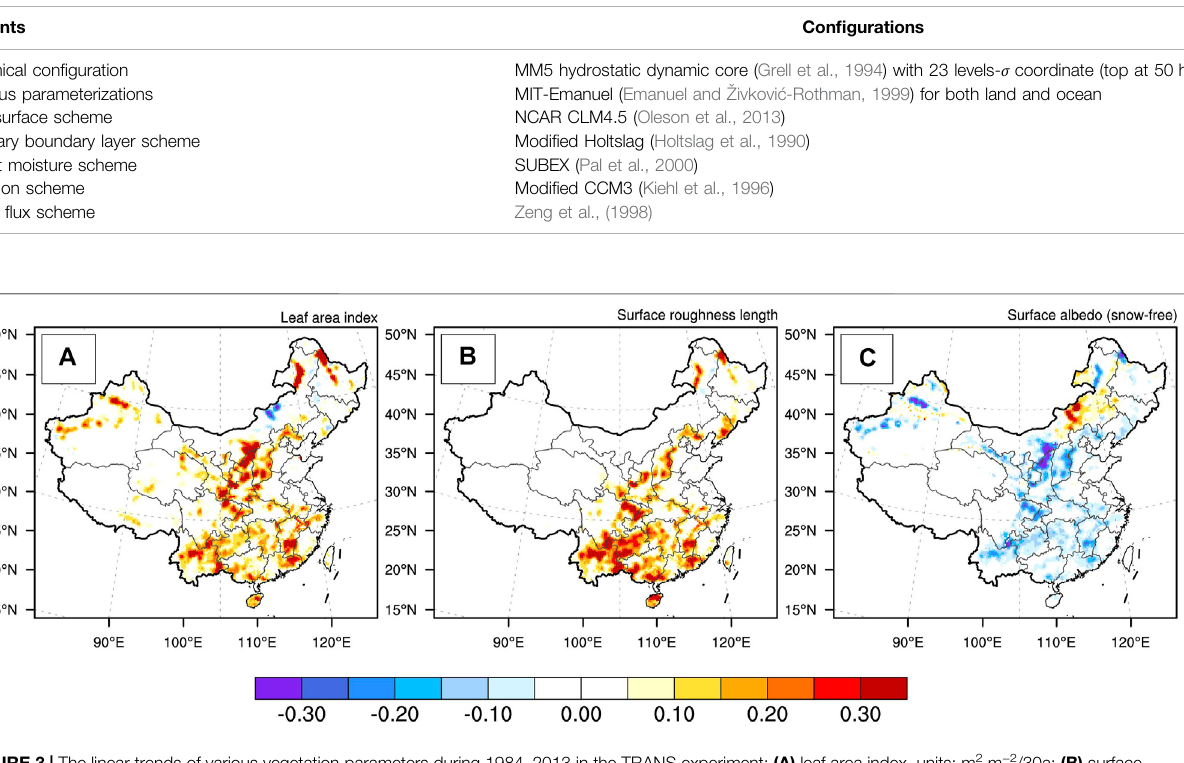
Frontiers in Environmental Science |